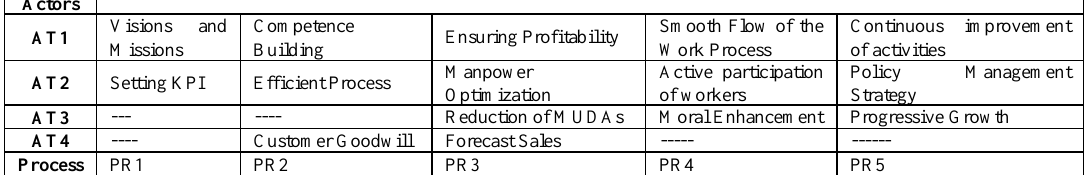
Table 11. Cross interaction interpretive matrix for actors and process in interpretive form.